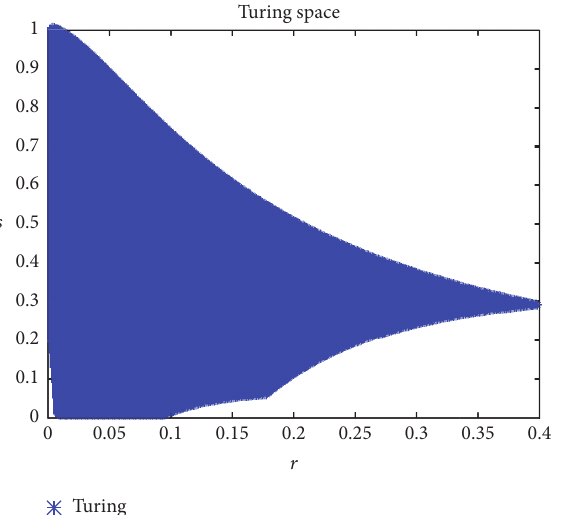
Figure 2: The values of the parameters here are 𝑑 1 = 10 −11 , 𝑑 2 = = 0.9 , 𝛾 = 0.01 , 𝑚 = 0.1 , 𝑢 = 0.13 , 𝑡 1.7 × 10 −8 , 𝑑 3 at the Turing space (sensitivity) generated by varying 𝑠 and 𝑟 , each in the range [0, 1] .